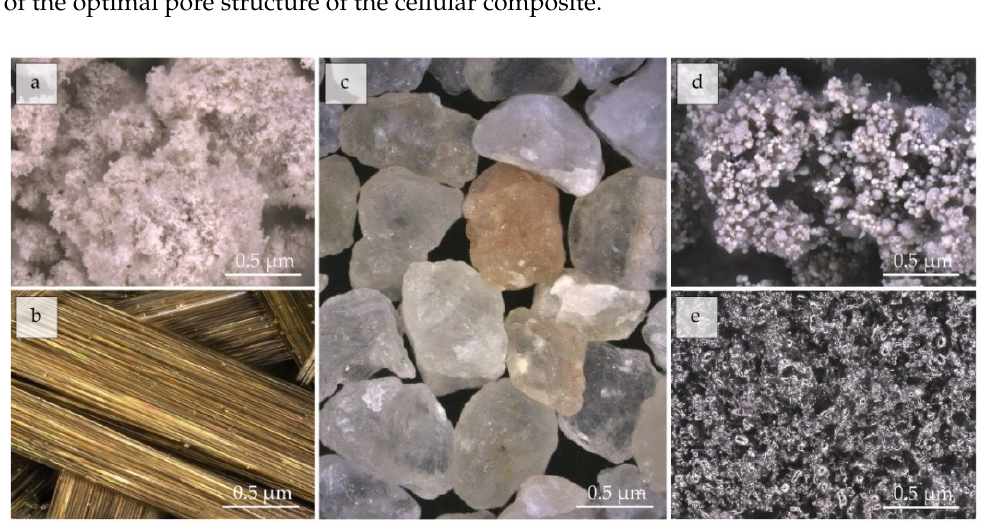
Figure 1. ( a ) Metakaolin, ( b ) chopped basalt fibers, ( c ) silica sand, ( d ) silica fume, and ( e )